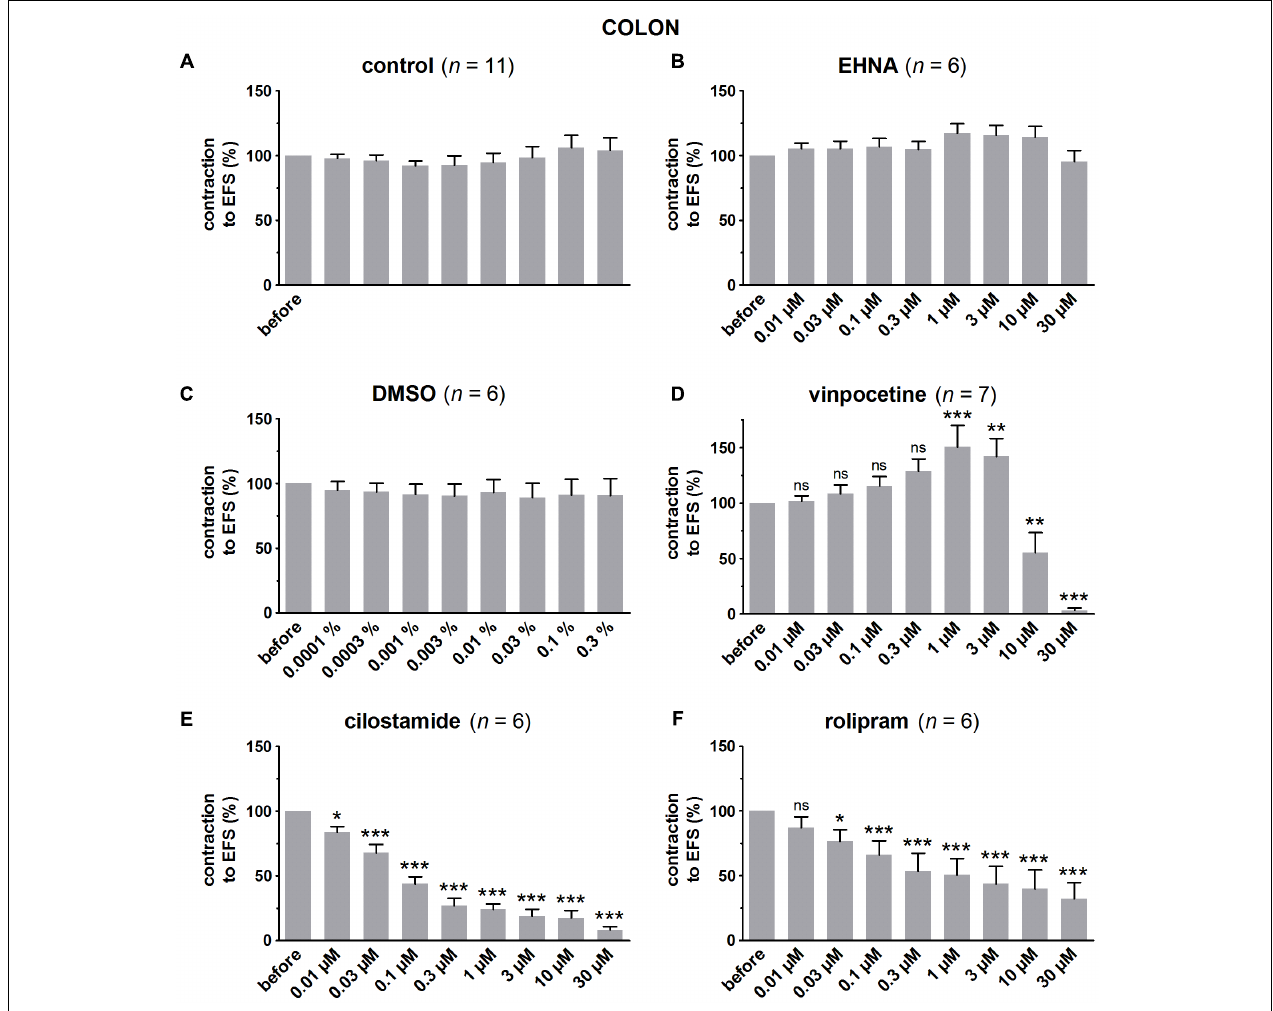
FIGURE 7 | Influence of increasing concentrations (0.01–30 µ M) of the PDE inhibitors EHNA (B) , vinpocetine (D) , cilostamide (E) and rolipram (F) , and the solvent DMSO (C) on submaximal electrically induced cholinergic contractions at V 50% (10 s trains at 8 Hz, 0.5 ms, interval of 5 min) in murine colon circular smooth muscle strips. Parallel time controls not receiving PDE inhibitor or solvent are shown in (A) . Five contractions were induced in the presence of each concentration of the PDE inhibitor and every 5 th contraction is shown, expressed as percentage of the mean of the five contractions before addition of the PDE inhibitor. Experiments were performed in the continuous presence of 4 µ M guanethidine, 300 µ M L-NAME, and 1 µ M MRS 2500. Means ± SEM; ns not significant, ∗ P < 0.05, ∗∗ P < 0.01, ∗∗∗ P < 0.001 versus reference before (repeated measures ANOVA with Bonferroni corrected t -test). For control, EHNA, and DMSO, the repeated measures ANOVA was not